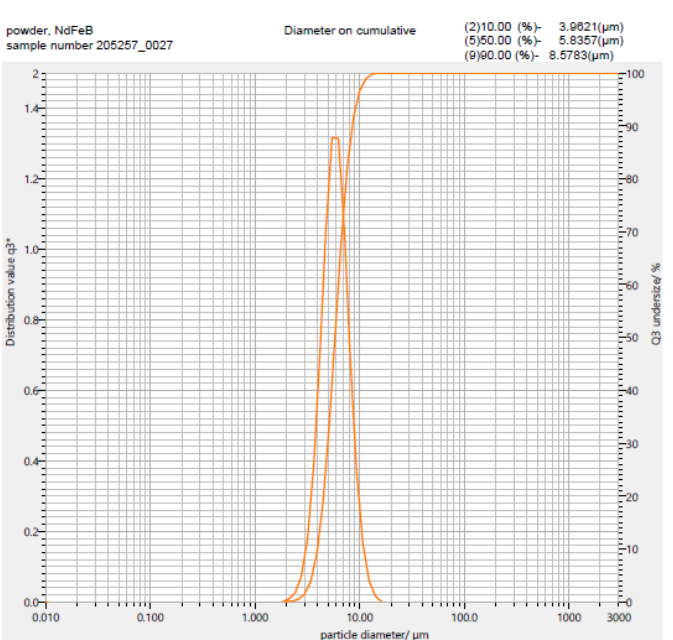
2 O 3 and ( b ) the NdFeB powder.